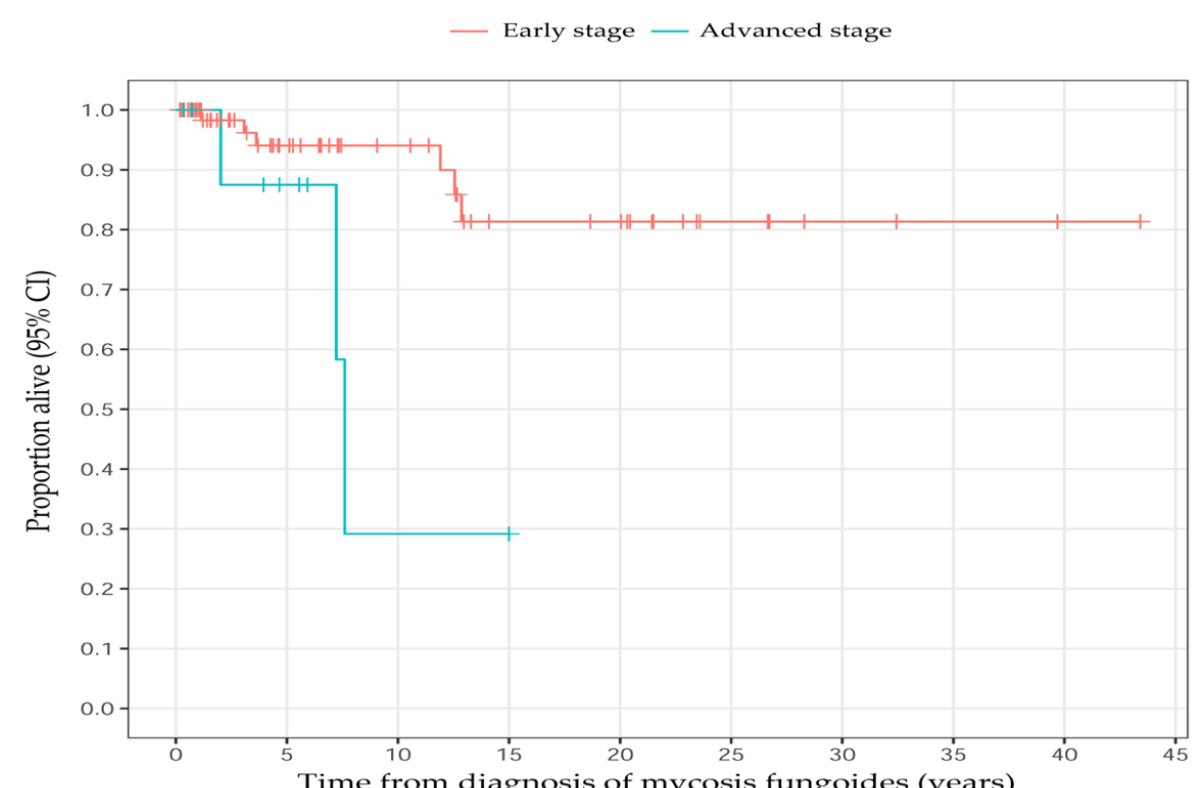
Figure 4. Kaplan – Meier survival plot for all patients with mycosis fungoides. The dotted lines are 95% confidence intervals (CI). The small vertical lines in red denote patients lost to follow-up.